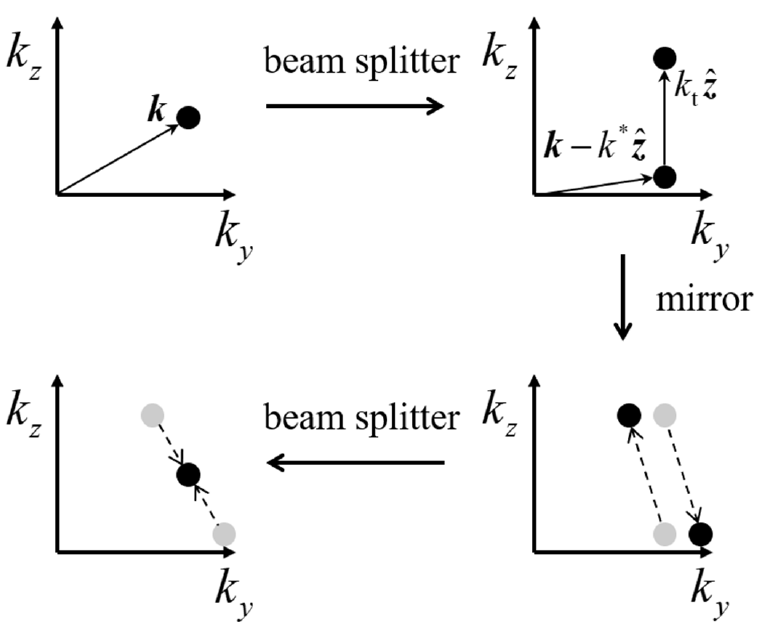
Figure 4. The evolution of a momentum eigenstate | k (cid:105) in the k − space in a PSI under rotation. A k − eigenstate is a single dot in the k − space. The first atomic beam splitter splits | k (cid:105) into a superposition of two k − eigenstates separated by the momentum transfer k t . The atomic mirror switches the position of the two k − eigenstates in the absence of rotation. In the presence of rotation, however, the two k − eigenstates will be shifted in the k y − direction. The second beam splitter will combine the two k − eigenstates and make them interfere. Due to the rotation induced phase shift, the population of the ground state will be (cid:10) atoms in the ground state, defined earlier. Consequently, if initially the atoms have a continuous distribution in the momentum space, the final distribution of the ground